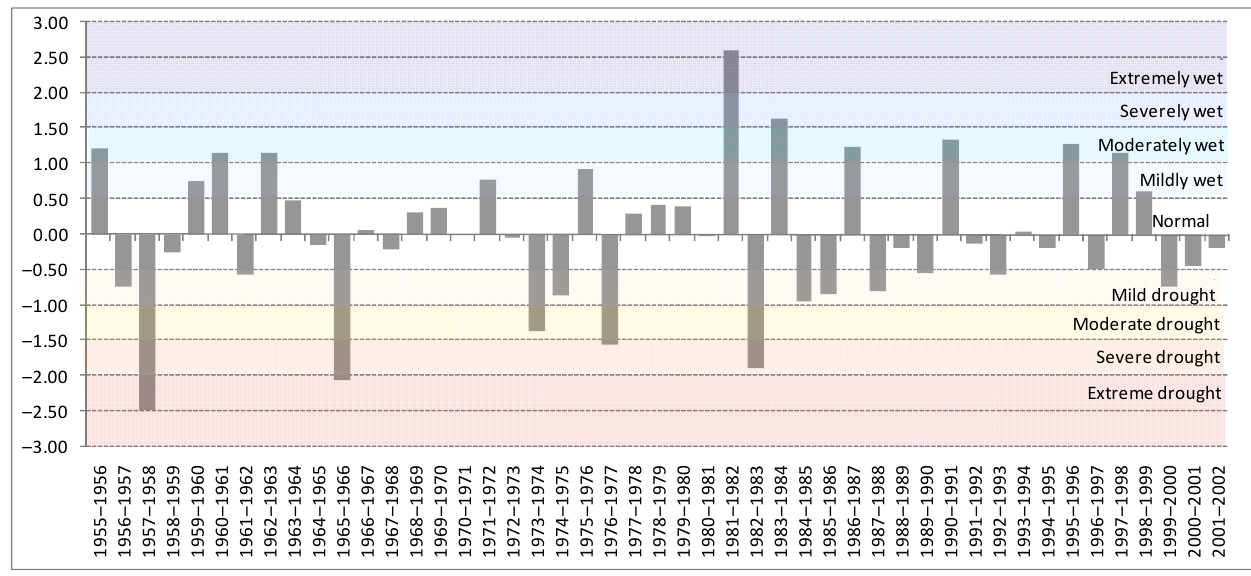
Figure 6. eRDI values (reference period: 6-month, December–May) with the corresponding drought severity classes (location: Larissa-Greece).